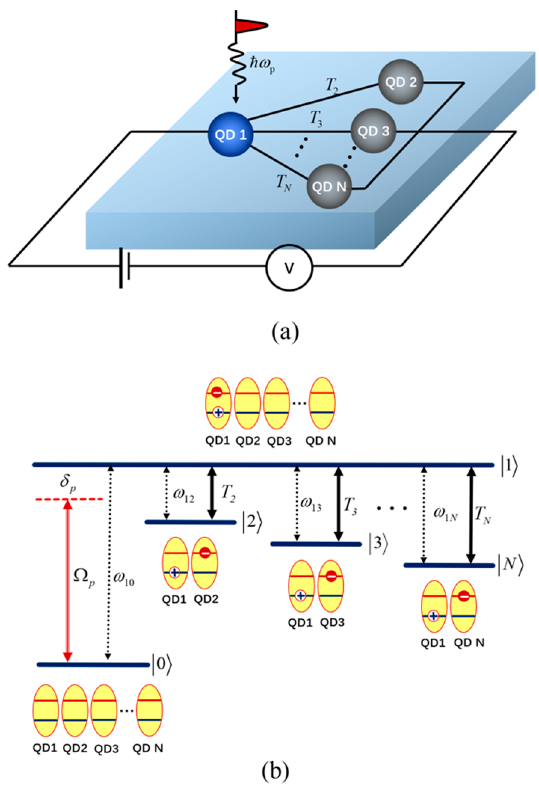
Figure 1. ( a ) The schematic of the setup of a multiple quantum dots (MQDs); ( b ) the schematic of the level configuration of a MQDs.